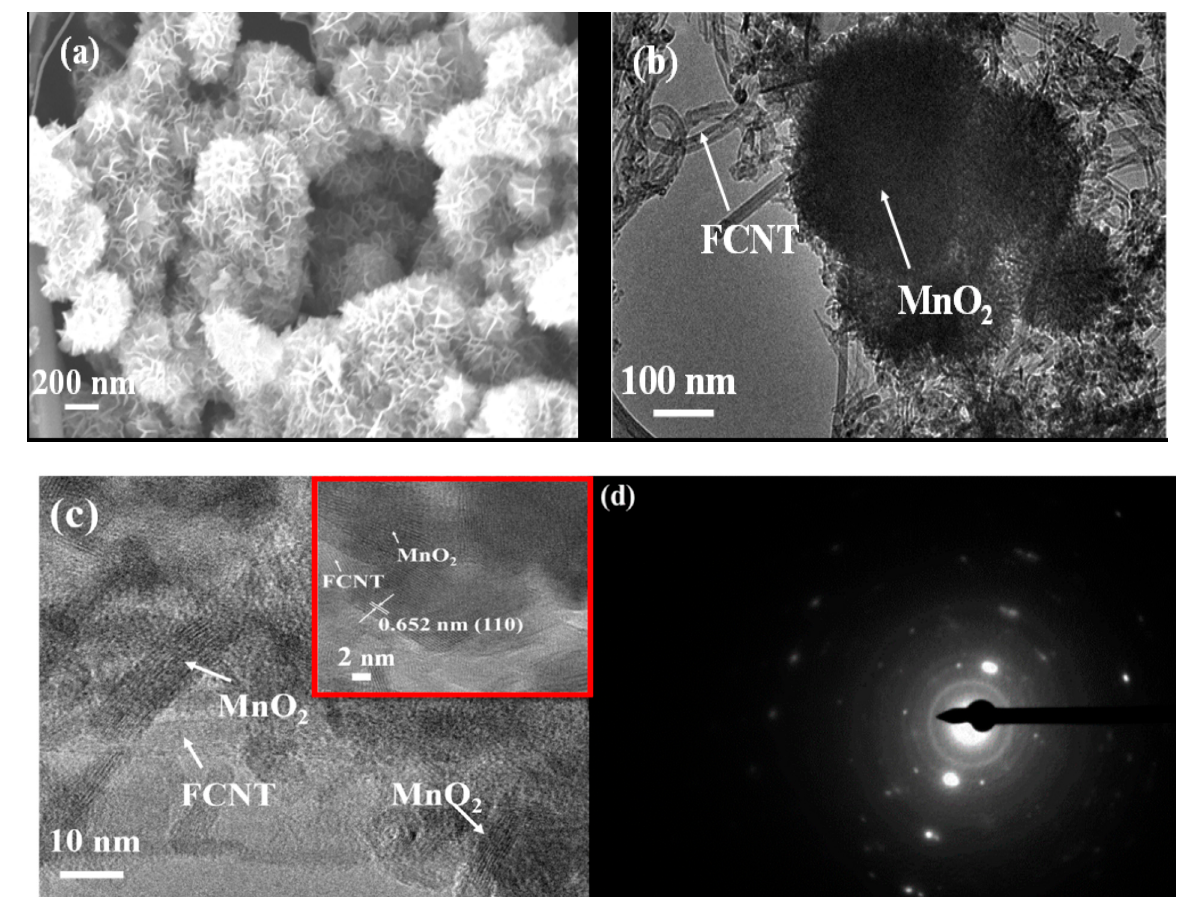
Figure 2. ( a ) FESEM of FCNT-MnO 2 , ( b ) TEM analysis of FCNT-MnO 2 , ( c ) HRTEM of FCNT-MnO 2 with inset showing the lattice spacing of MnO 2 in the hybrid FCNT-MnO 2 , and ( d ) SEAD pattern of FCNT-MnO 2 .